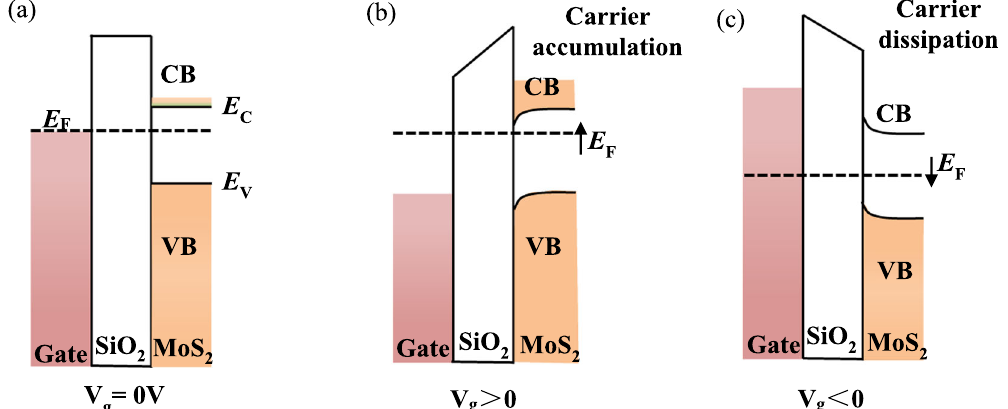
Fig. 5 Energy band diagram of atomically thin MoS 2 with n-type semiconductor properties. a Energy band diagrams of atomically thin MoS 2 at equilibrium. b The energy band bending and electron accumulation caused by the existence of donor-like surface states under the positive gate voltage. The band diagram of the MoS 2 /SiO 2 /Si structure. c The band diagram of the MoS 2 /SiO 2 /Si structure at negative gate voltage. The energy band bending and surface electron depletion under the negative gate